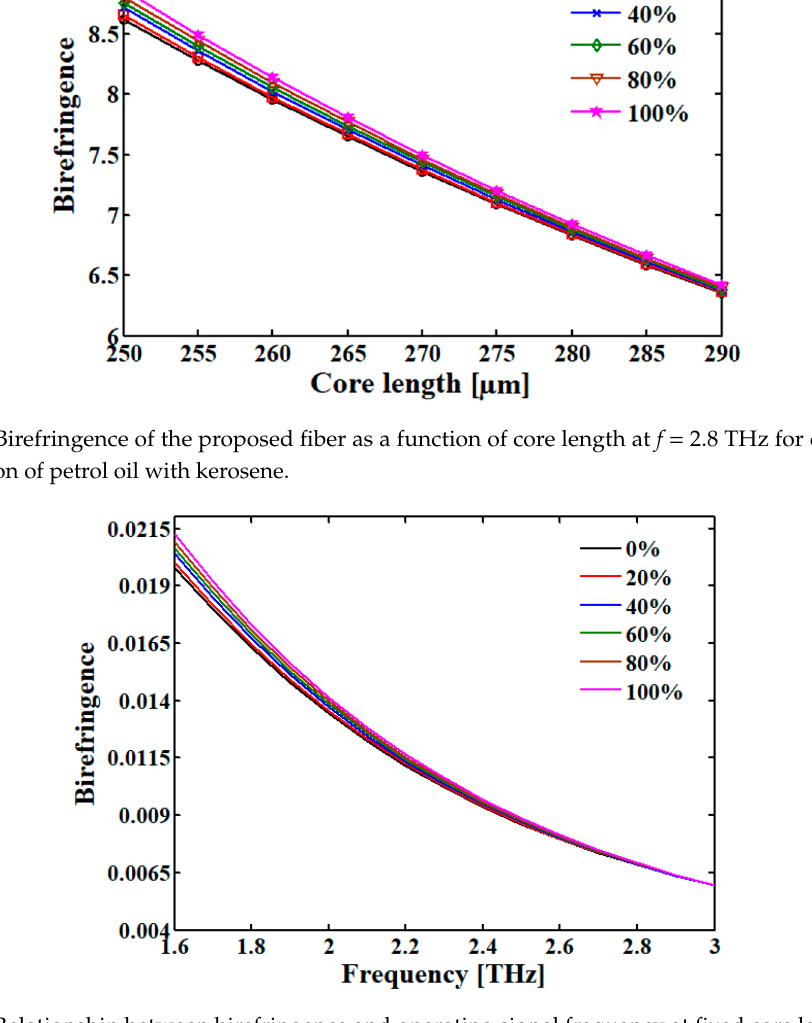
Figure 9. Relationship between birefringence and operating signal frequency at fixed core length for different percentage of mixture of kerosene oil in petrol.